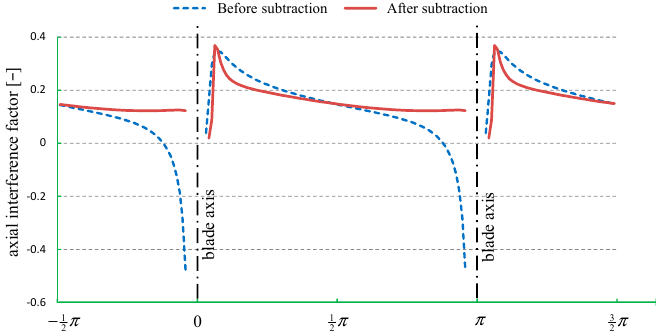
Figure 9. Variation of axial interference factor with azimuthal angle in the rotor plane at r / R = 47%